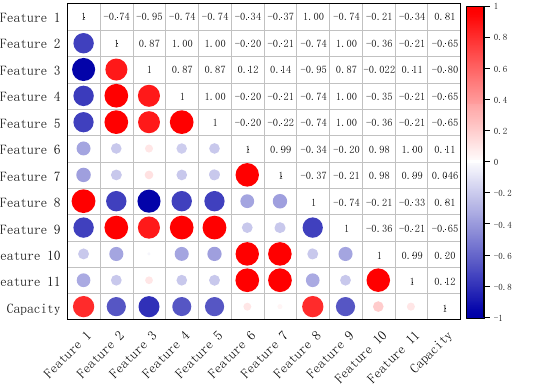
Figure 6. Pearson correlation coefficient between the optimal features and prediction of battery